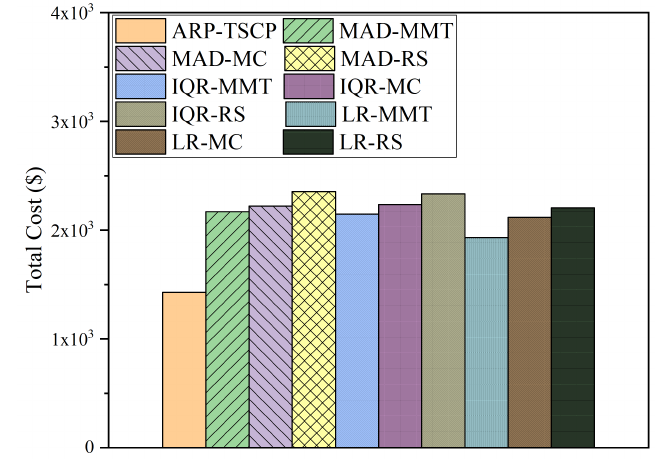
Figure 16. Comparing the total cost by all